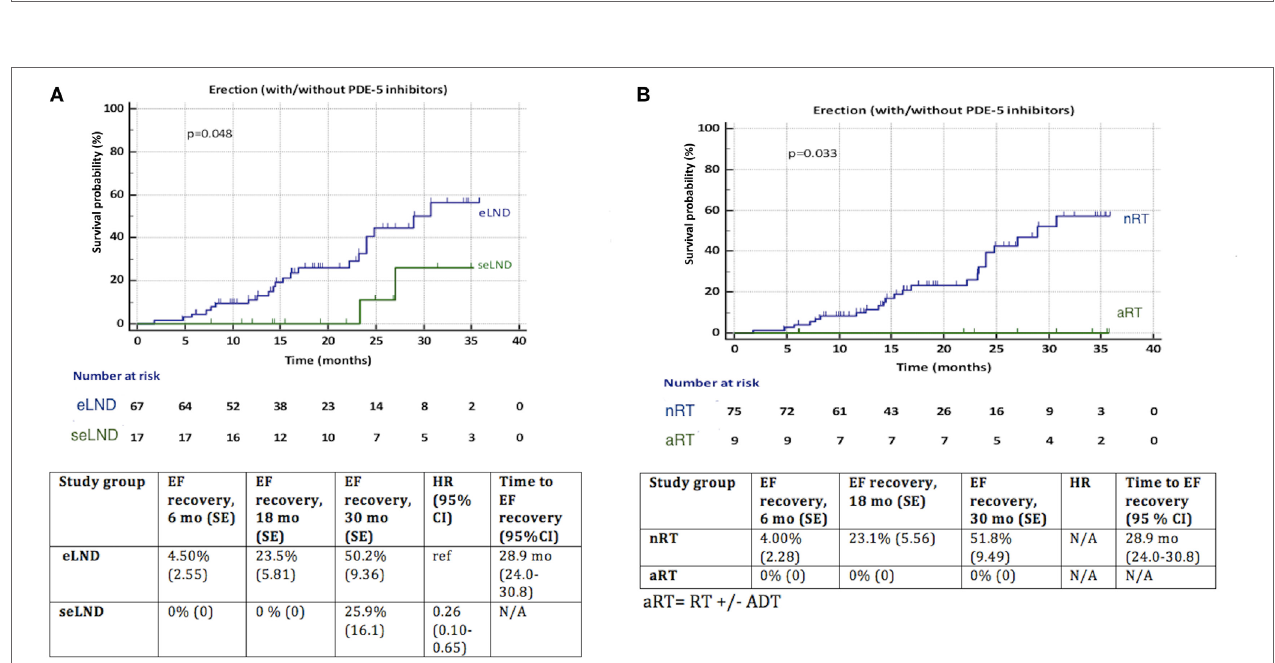
FigUre 5 | Recovery of erectile function among patients with adjuvant radiotherapy (aRT) versus no aRT. HR, hazard ratio, mo, months, CI, confidence interval, ref, reference, SE, standard error.